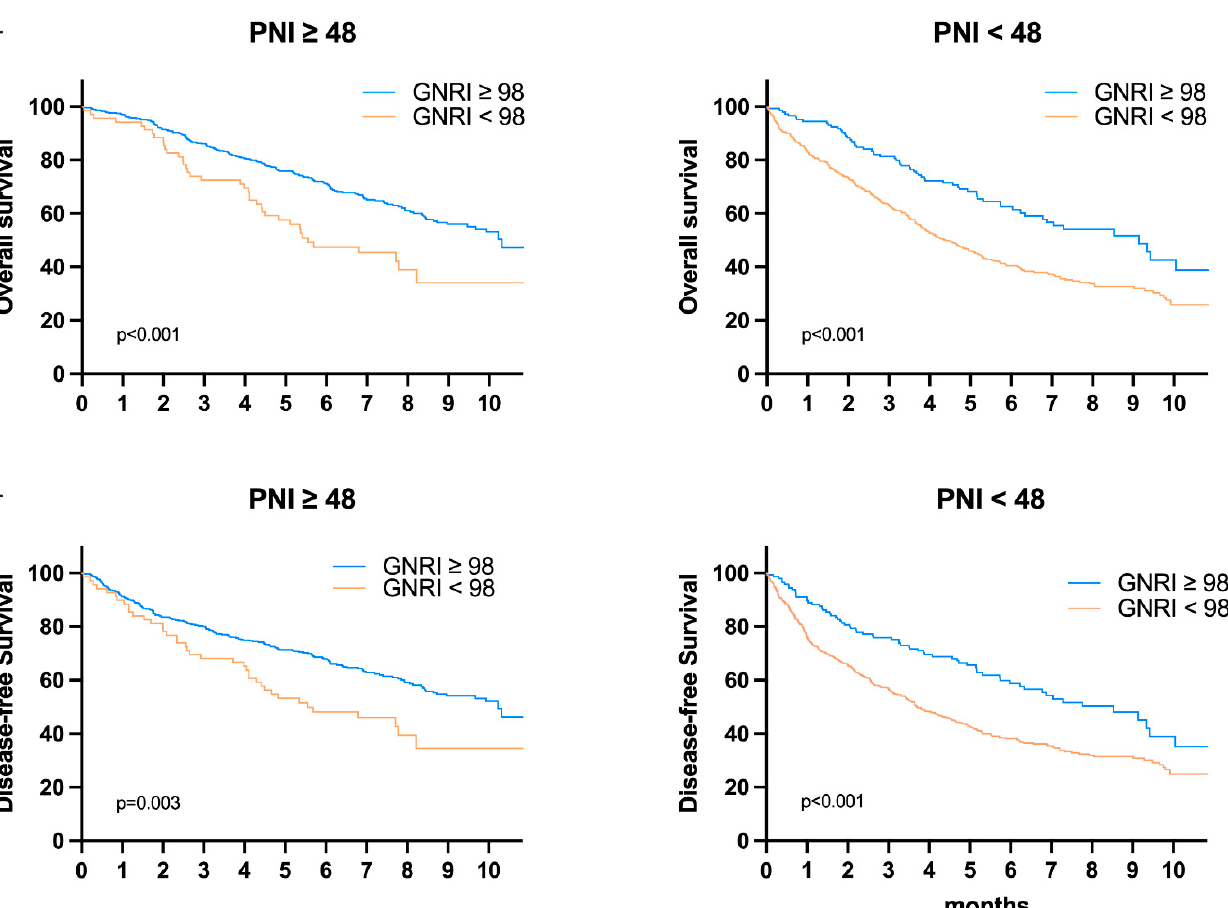
Figure 6. Kaplan–Meier survival analysis of ( a ) OS and ( b ) DFS according to GNRI in the PNI < 48 or PNI ≥ 48 subgroup.